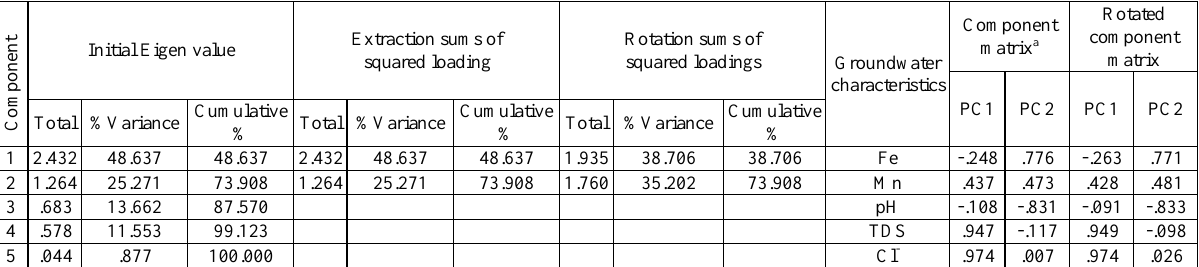
Table 3. Principal component analysis (total variance) (winter) Extraction sums of squared loading